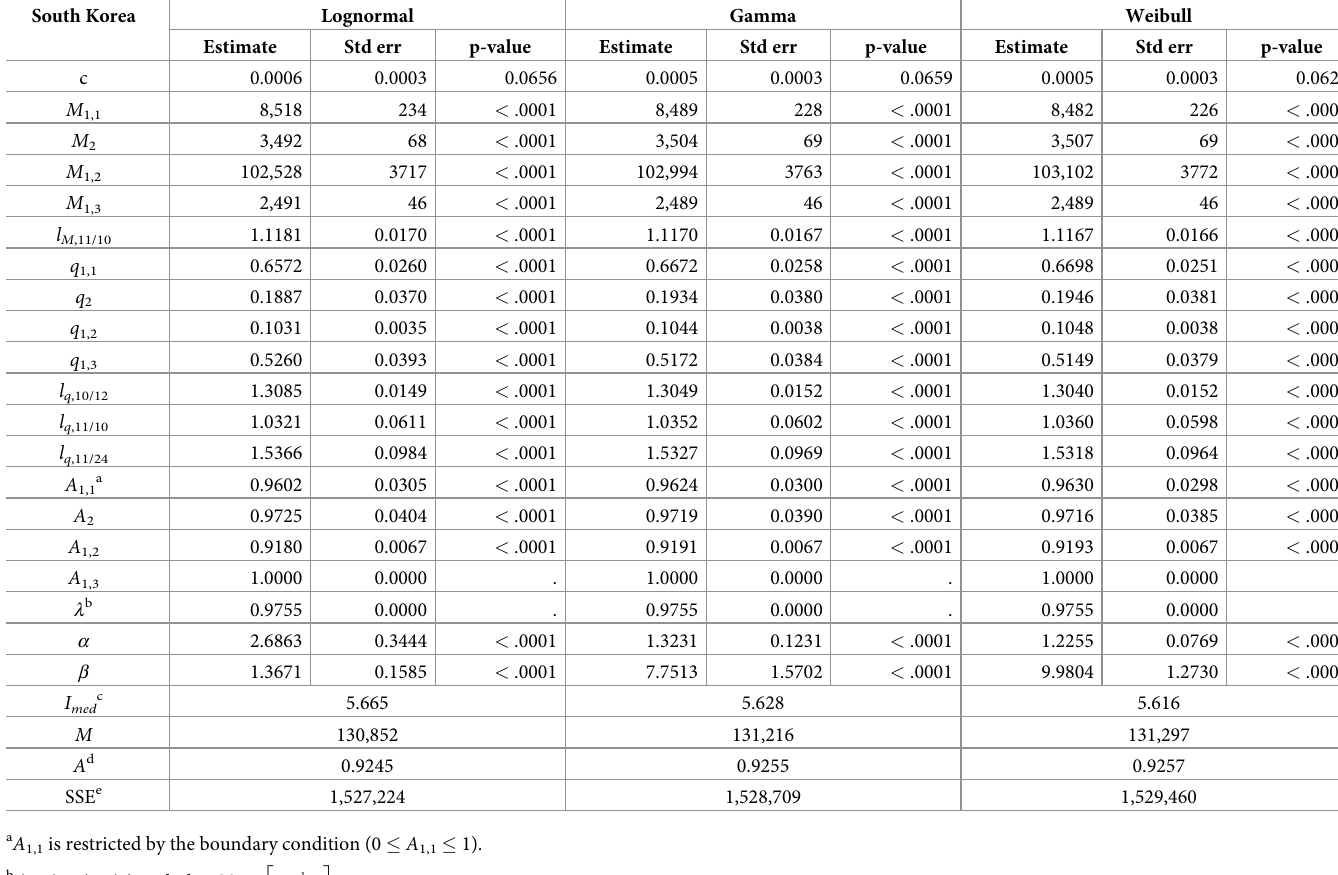
Table 3. Comparison of model fit and parameter estimates for confirmed cases in South